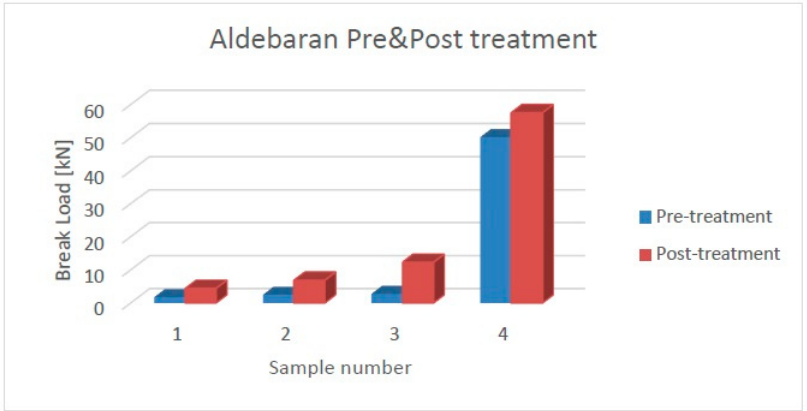
Figure 11. Aldebaran pre- and post-treatment samples compression strength. Materials 2018 , 11 , x FOR PEER REVIEW